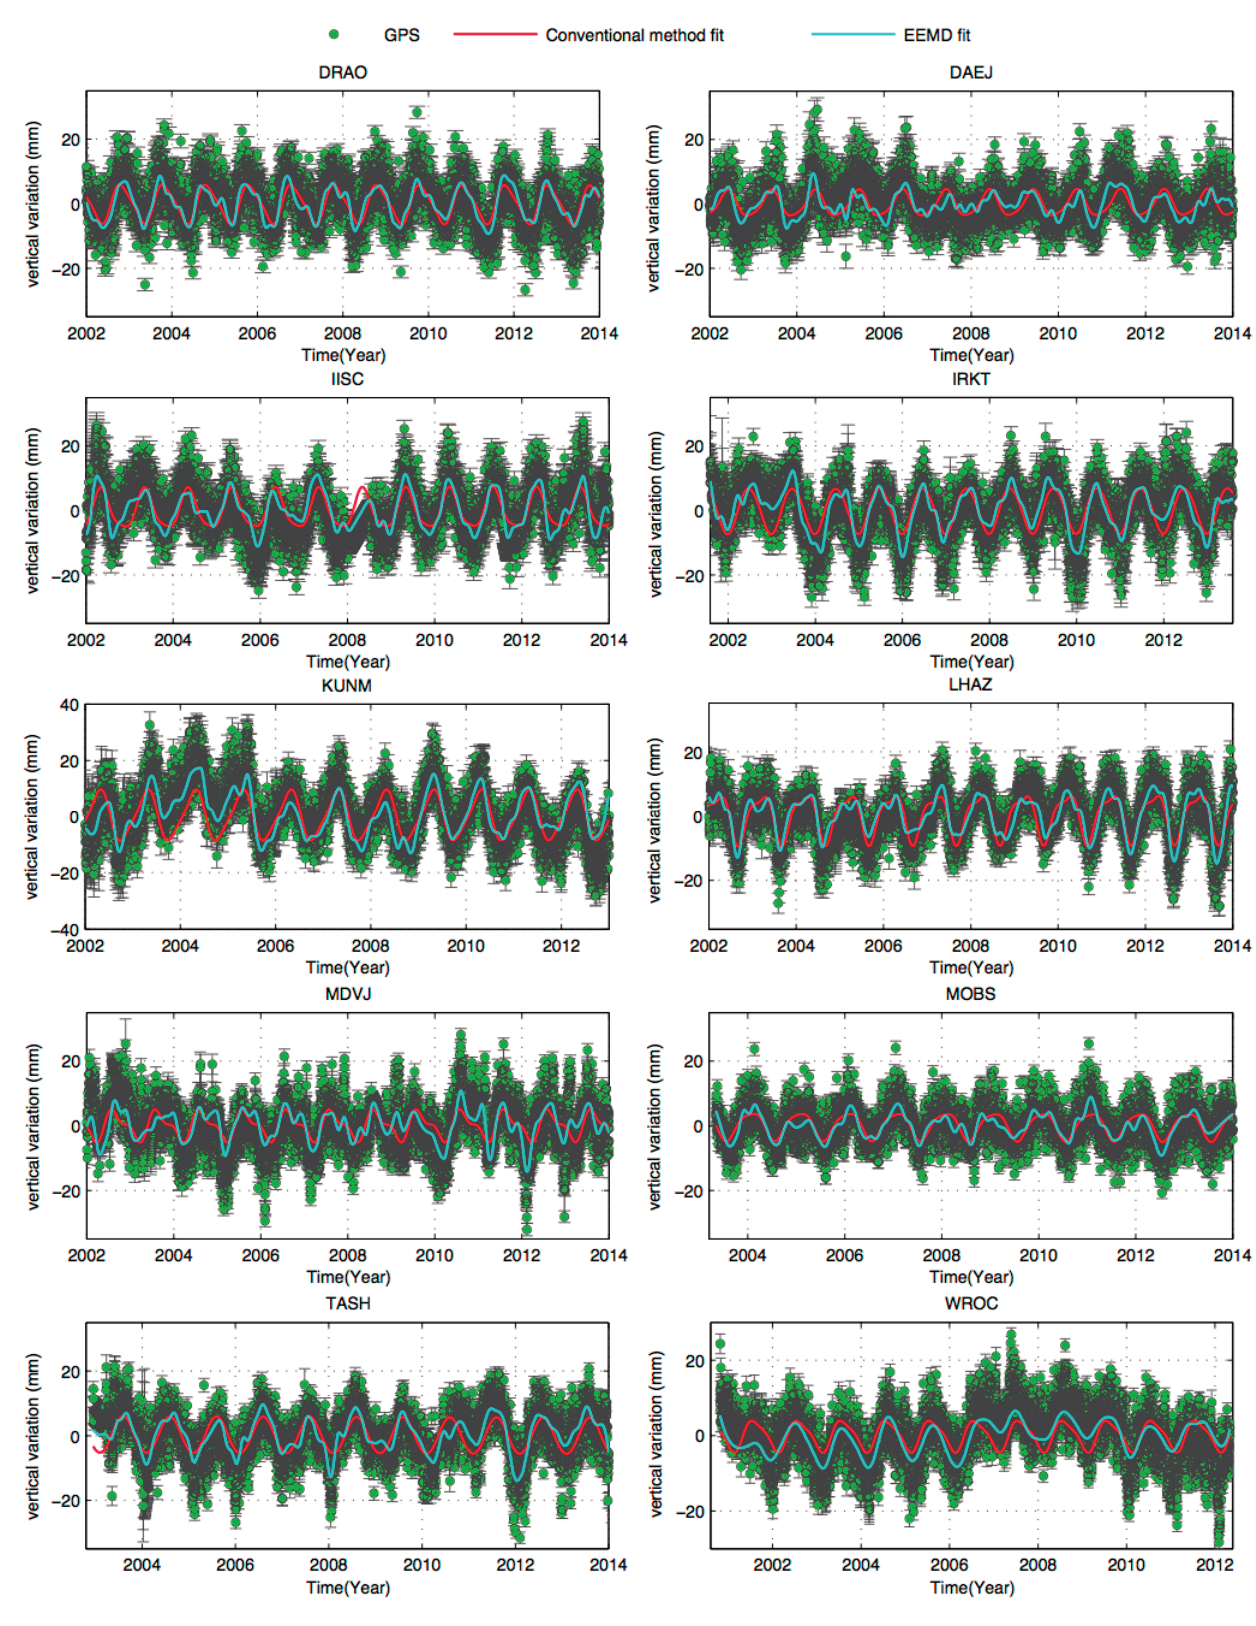
Figure 6. The original vertical GPS time series (green) with one sigma-error bars. The de-trended series formed by IMF6 + IMF7 + IMF8 is given in light-blue, and the red curve is from the LS fitting by the annual and semi-annual sinusoidal